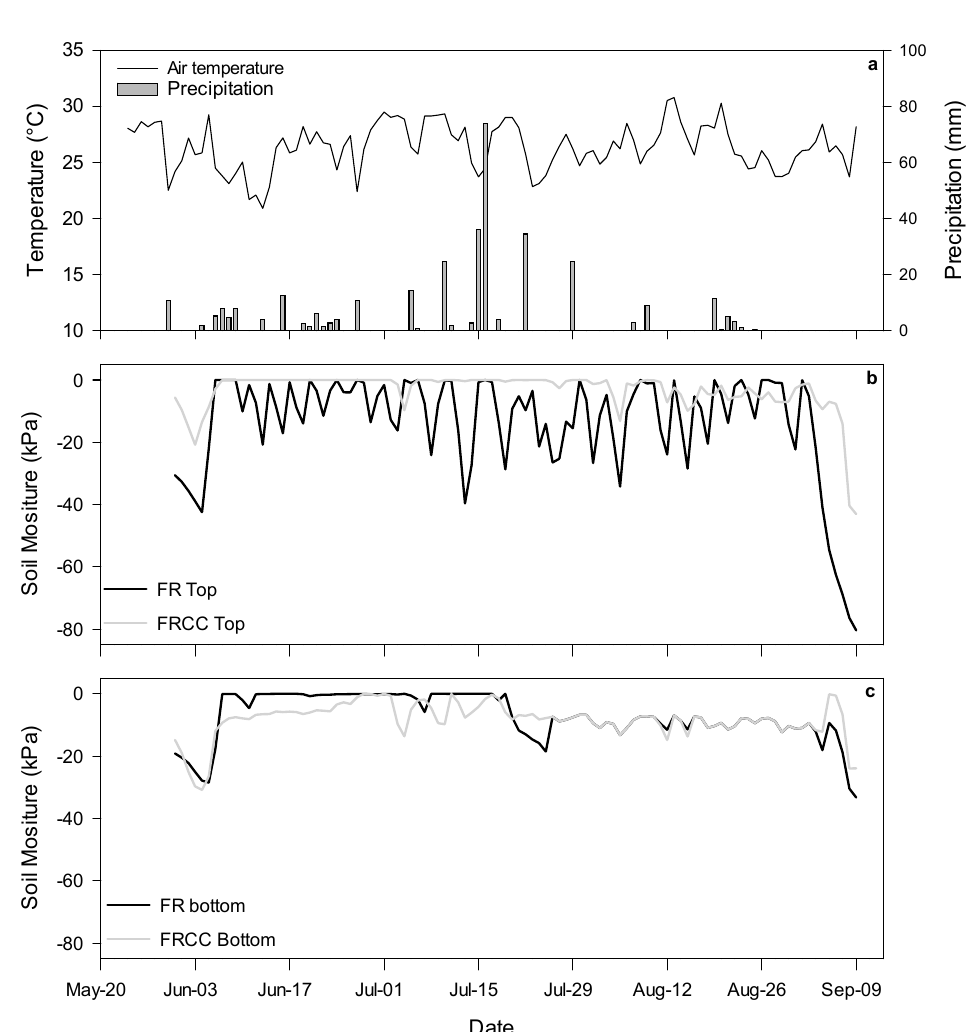
Figure 2. ( a ) Average daily air temperature and precipitation, ( b , c ) soil water content (15 cm) at the top and bottom sections of a furrow-irrigated rice field (FR) and a furrow-irrigated rice with cover crops field (FRCC).